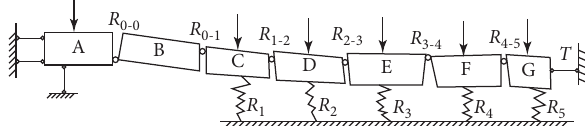
Figure 2: The bond-beam structure of the rock mass in the mining